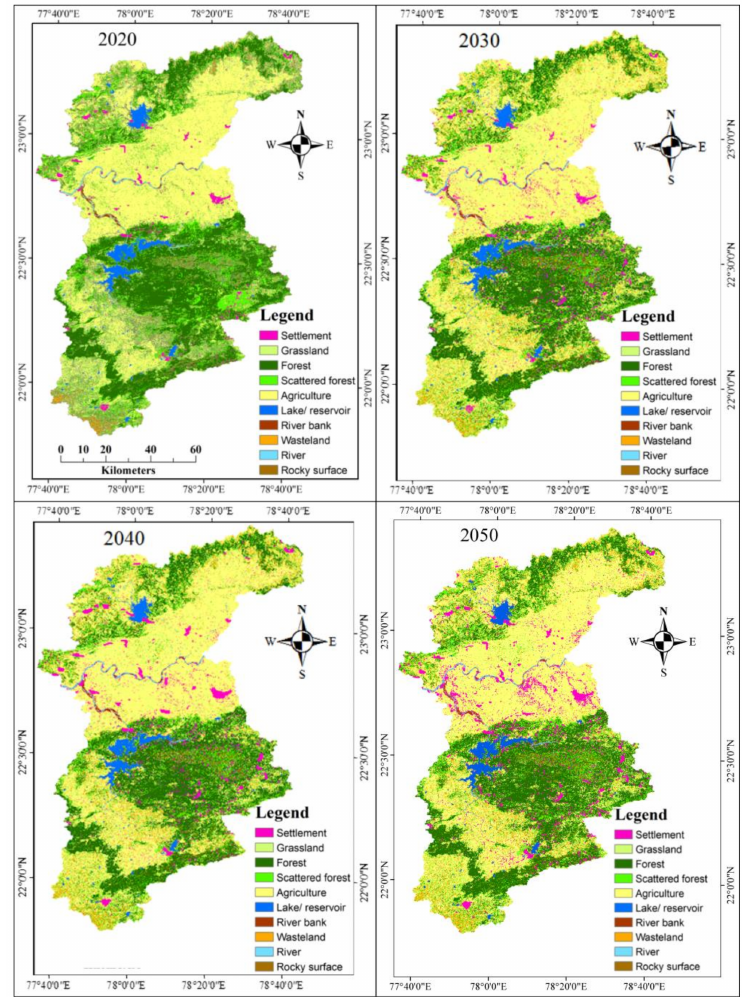
Figure 7. Land use maps of 2020, 2030, 2040 and